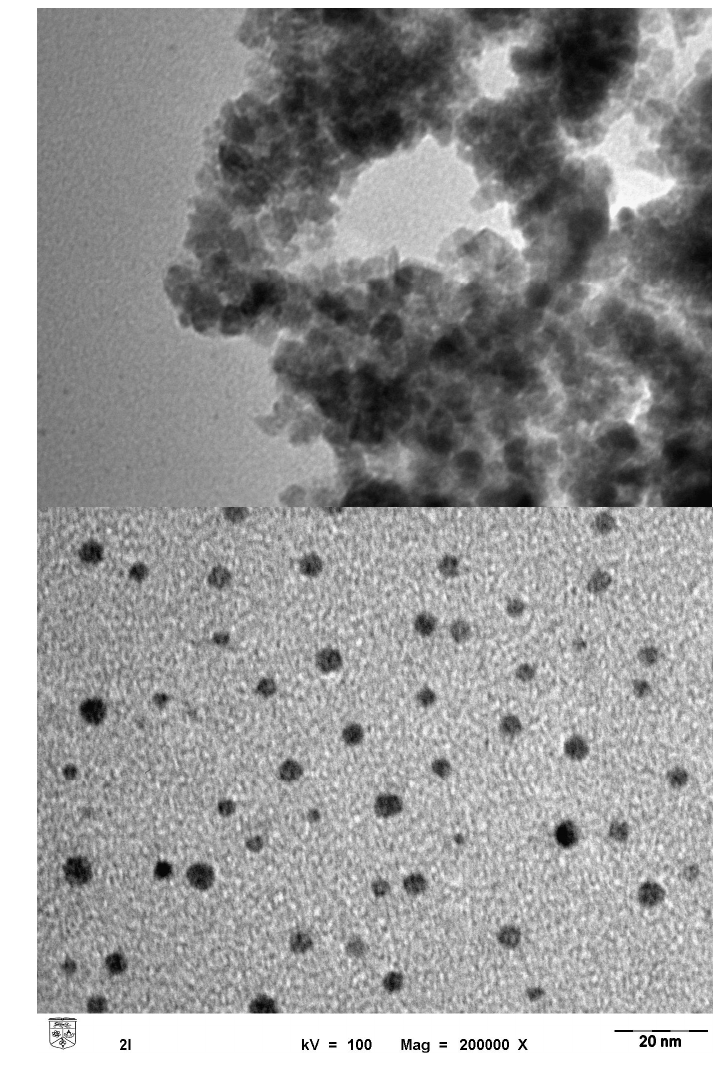
Figure 2. The transmission electron micrograph showing the size and distribution of Fe O nanoparticles in ethanol solution (a) and ALP solution 3 4